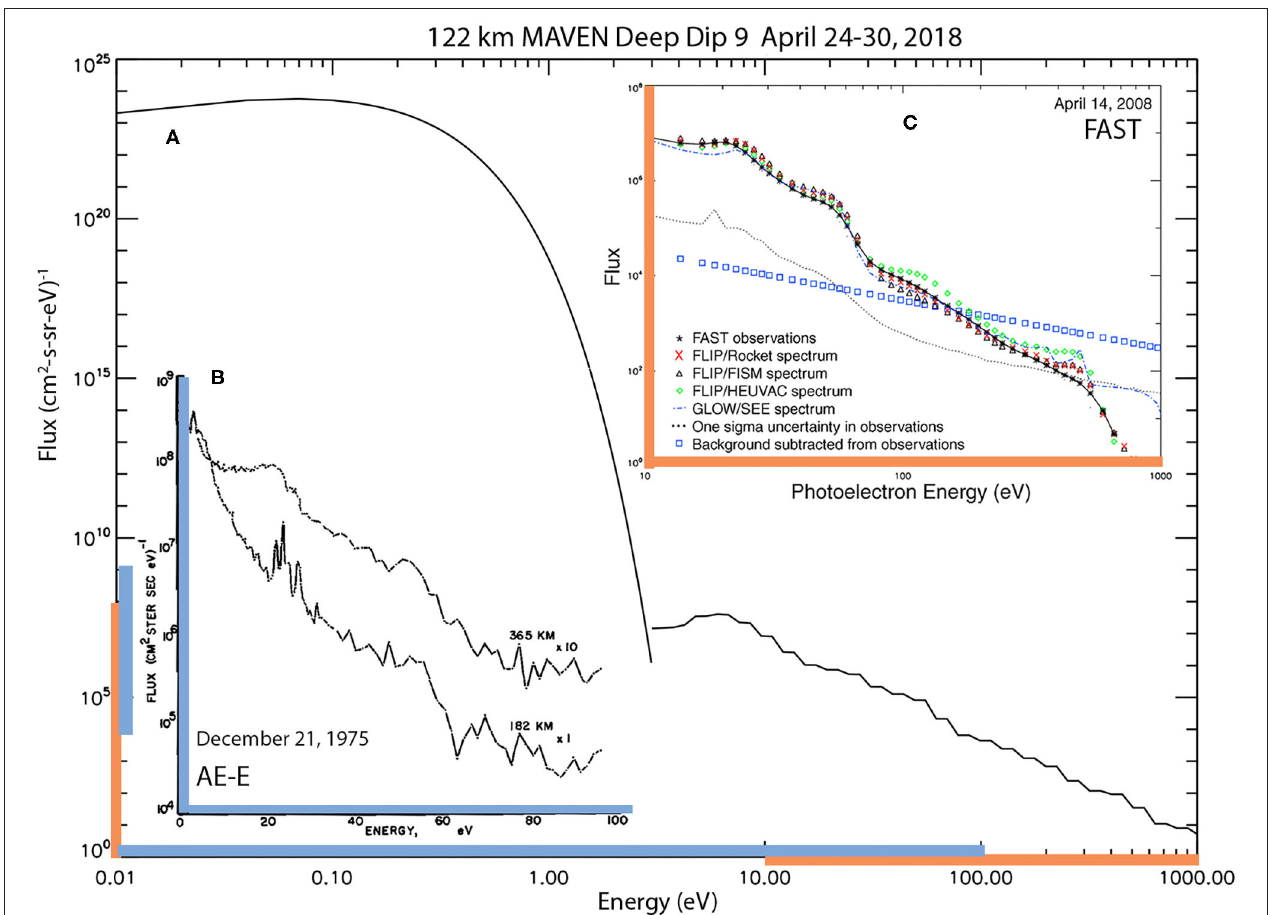
FIGURE 1 | Photoelectron energy spectra in units of number flux (cm 2 -s-sr-eV) − 1 vs. energy from MAVEN (A) , AE-E (B) , and FAST (C) . MAVEN data were acquired at 122km, below the region of maximum photoelectron production. AE-E data were acquired at 182 and 365km near and above the region of maximum photoelectron production. FAST data were acquired above 1,000km in the source cone as described in the text. The number flux ranges for AE-E (blue) and FAST (orange) are sub sets of the MAVEN range as indicated. The AE-E energy scale (blue) is linear; it is logarithmic for FAST (orange) and MAVEN. The solar zenith angles (SZA) for AE-E observations presented are 50 ◦ at 182km and 37 ◦ at 365km. For MAVEN it is 54 ◦ at 122km. For FAST, above 1,000 and for SZA’s < 90 ◦ Peterson et al. (2008) demonstrated that the escaping photoelectron flux is insensitive to the